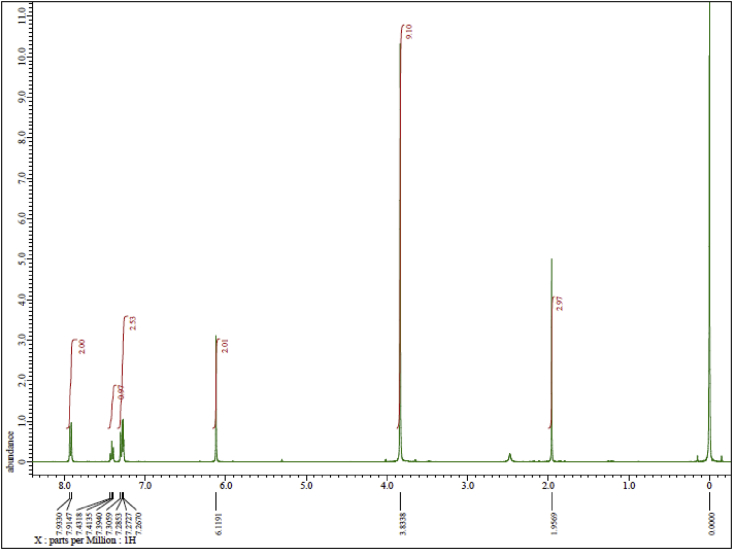
1H NMR spectrum of Ph(TMP)IOAc.